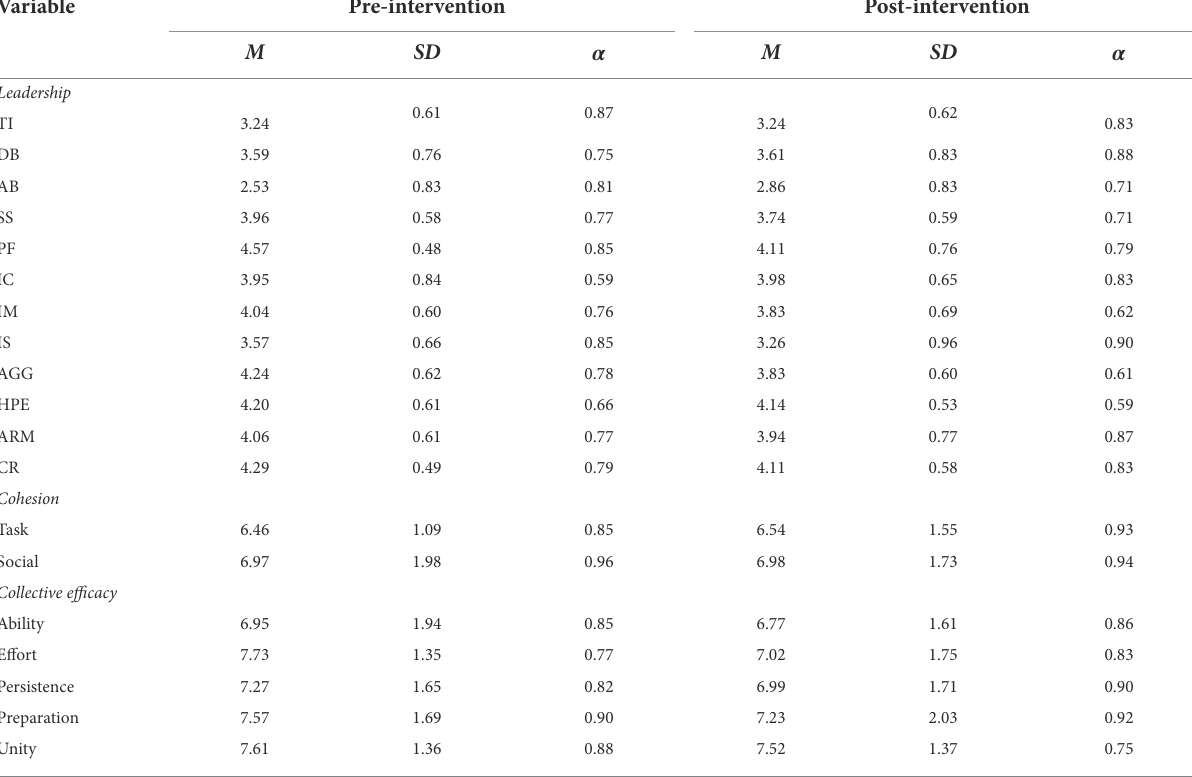
TABLE 3 Descriptive statistics for athlete leadership behaviours, cohesion, and collective efficacy.